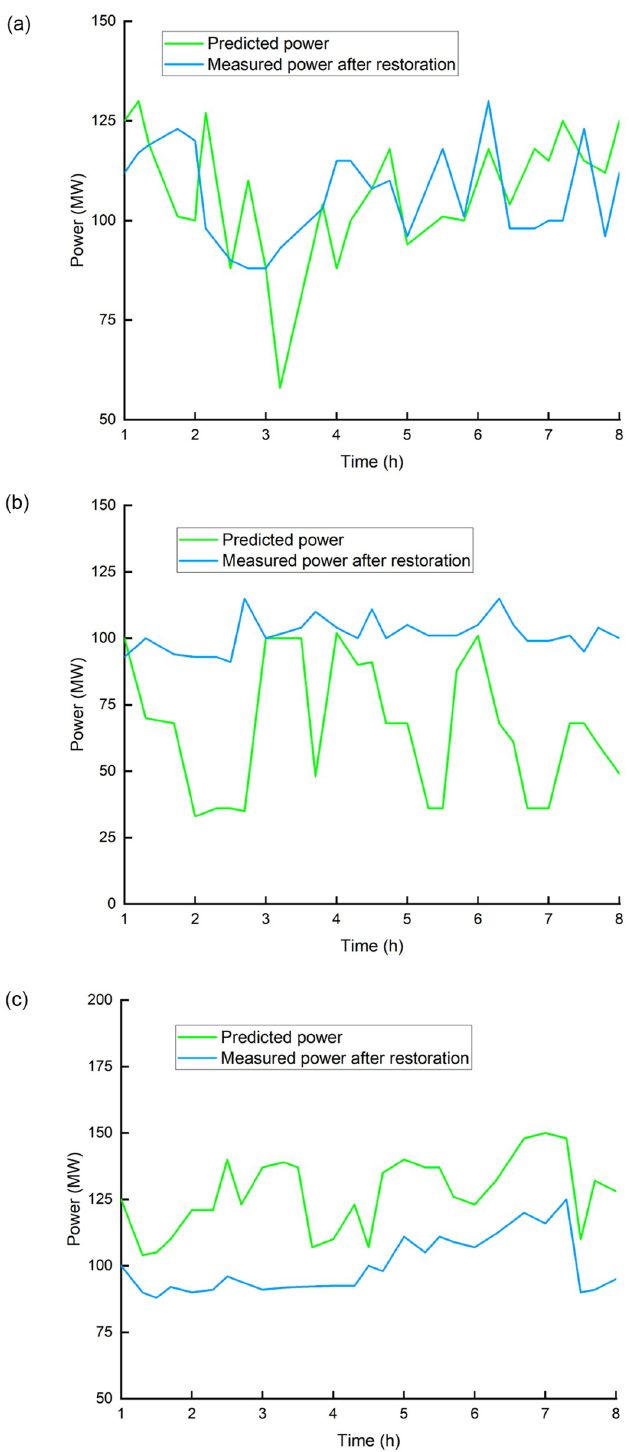
Fig 4. Farecasting and measured power output of wind farms. (a) Actual control effect, (b) Control deviation comparison.